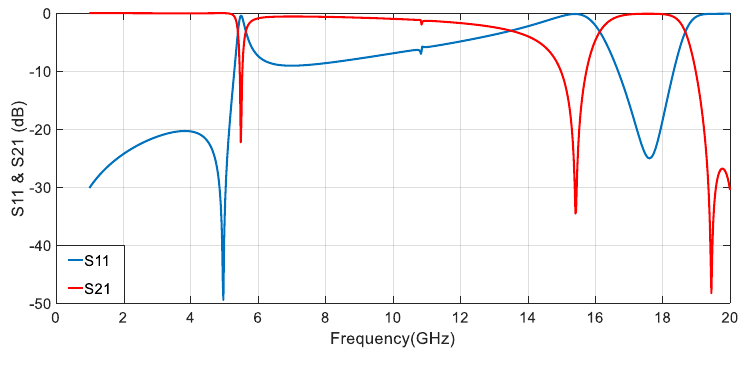
Figure 17. S 11 and S 21 for square SRR.